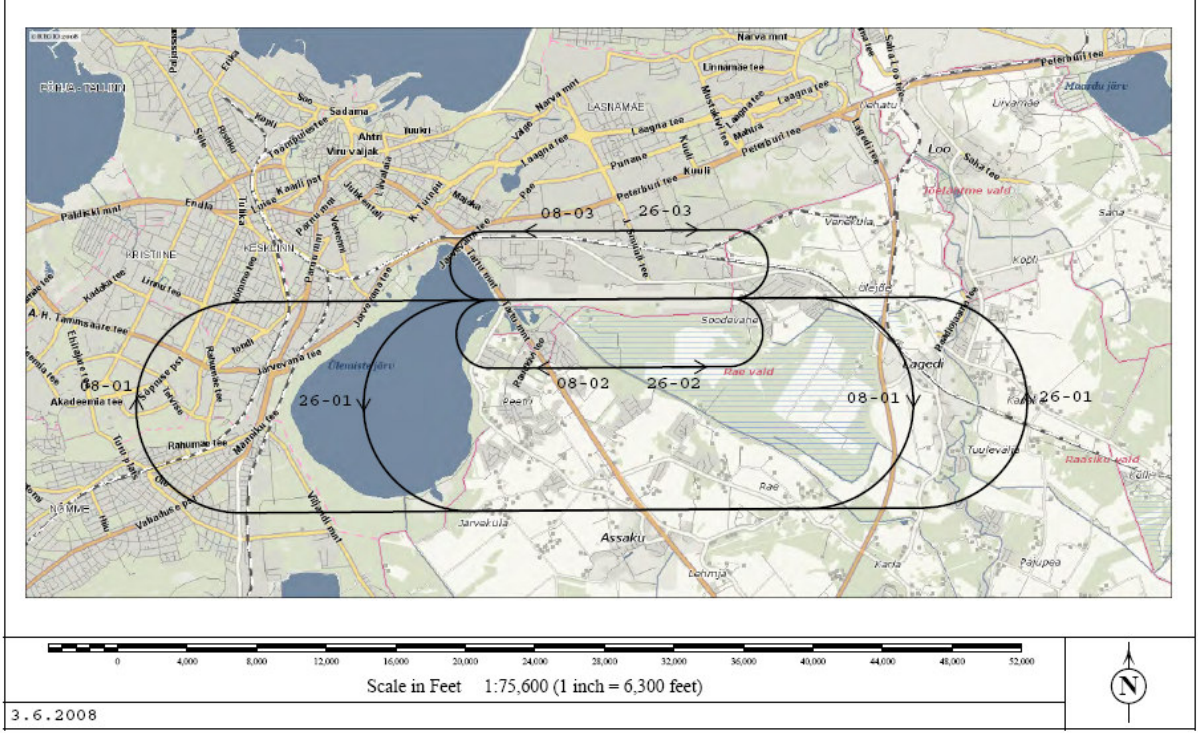
Fig 3. Tallinn Airport. Noise map according to Directive 2002/49/EC. Air corridors for training purposes